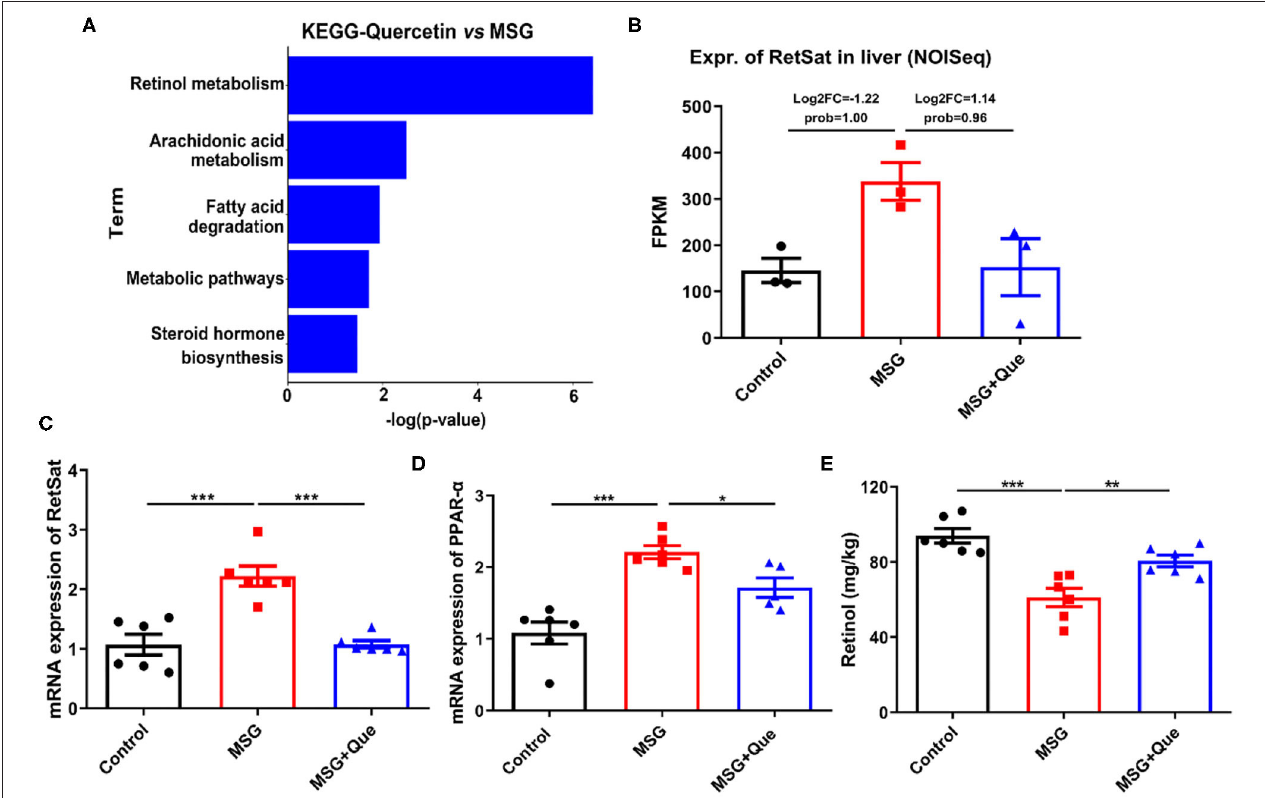
FIGURE 6 | MSG-induced liver RetSat up-regulation is downregulated after the quercetin treatment. (A) The functional enrichment of DEGs in the MSG and quercetin-treated group. (B) Transcriptome analysis of RetSat in the control, MSG and quercetin-treated group. (C) mRNA expression of liver RetSat. (D) PPAR- α mRNA level in the liver tissue. (E) Retinol content in the liver tissue. FPKM: Fragments per Kilobase Million. Data are presented as mean ± SEM, n = 3–6. Data were analyzed by one-way ANOVA followed by post-hoc LSD tests. * p < 0.05, ** p < 0.01, *** p <